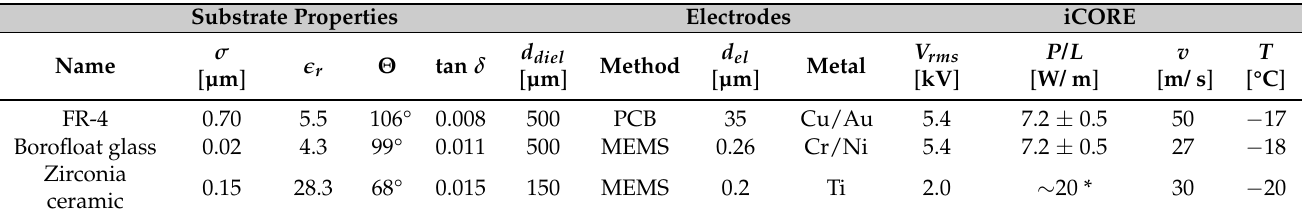
Table 1. Overview of the measured materials, the measured surface roughness ( σ ), the dielectric constant ( (cid:101) r ), the contact angle ( Θ ), the loss tangent ( δ ), the used substrate/dielectric thicknesses ( d diel ), the manufacturing processes (method), the electrode thickness ( d el ) and the electrode material. The table also shows the icing wind tunnel parameters at which the experiments were conducted, namely the operation Voltage ( V rms ) of the SDBD and its measured power scaled to the electrode length ( P / L ), the applied air speed ( v ) and the temperature ( T ). * estimated from measurements at ambient air.